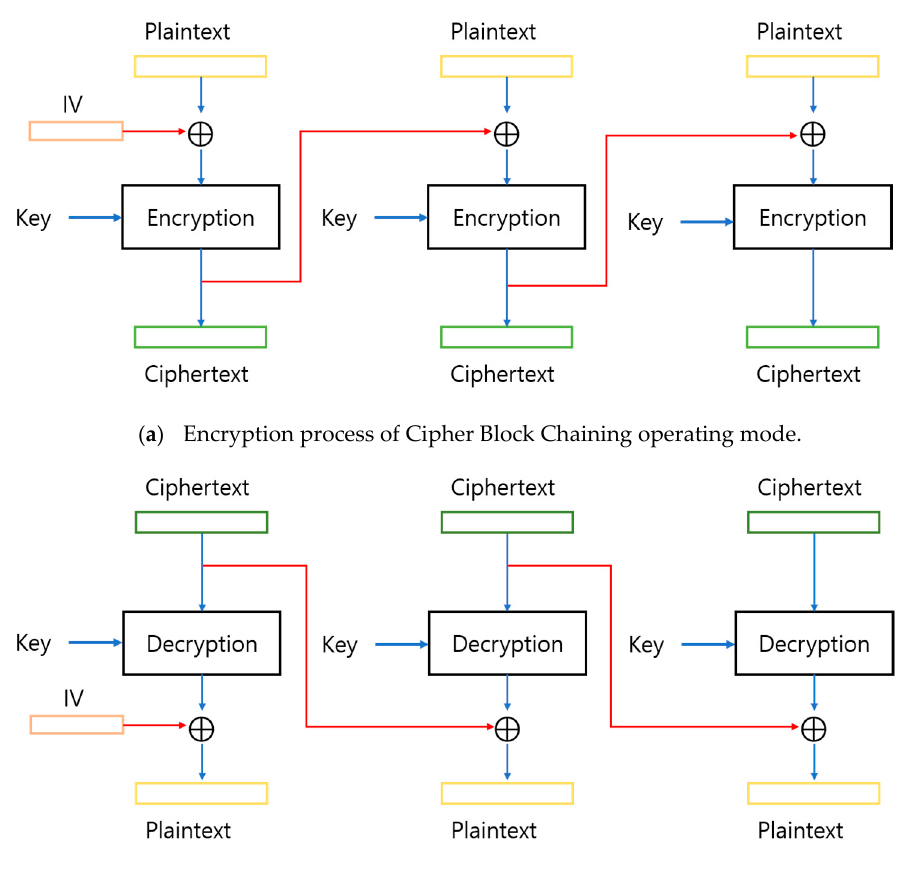
Figure 3. Block Diagram of Cipher Block Chaining operating mode (CBC), ( a ) Encryption process, ( b ) Decryption process [25].